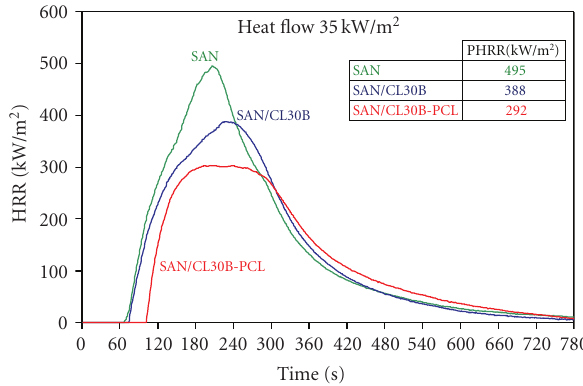
Figure 6: Comparison of the heat release rate (HRR) plots and peak of heat release rate (PHRR) of SAN, SAN/CL30B and SAN/CL30B- PCL with 3wt% of inorganics at 35 kW/m 2 heat flux.